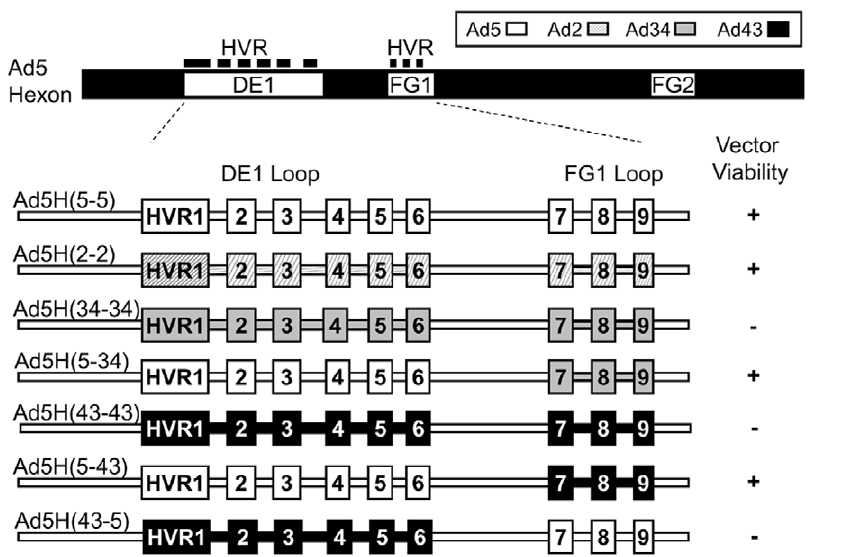
Figure 1. Generation of Ad5 vectors with chimeric hexons derived from Ad2, Ad43 and Ad34. A schematic view of the Ad5 hexon protein and viable chimeric vectors is shown. The positions of surface loops (DE1 and FG1) within the hexon protein are indicated. The HVRs 1–9, indicated in black, are shown above the Ad5 hexon. Sequences from Ad5 are indicated in white, Ad2 in diagonal stripes, Ad34 in gray and Ad43 in black. Viable vectors produced were: Ad5H(5–5) containing the wild-type Ad5 hexon; Ad5H(2–2) containing the Ad2 DE1 and FG1 loops; Ad5H(5–43) containing the FG1 loop from Ad43; and Ad5H(5–34) containing the FG1 loop from Ad34.